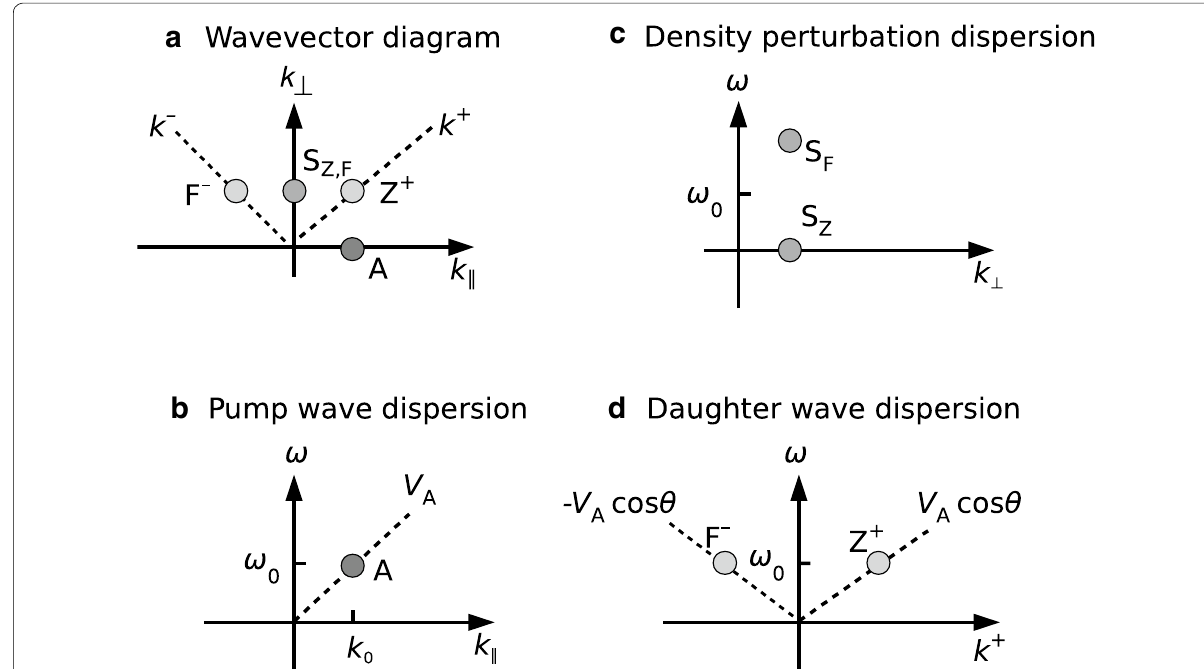
Fig. 1 Three-wave coupling of the zero-frequency and fast-mode instabilities in the wavevector domain spanning parallel and perpendicular directions ( a ) and in the frequency–wavenumber domain parallel ( b ), perpendicular ( c ), and oblique at θ angle ( d ) to the mean magnetic